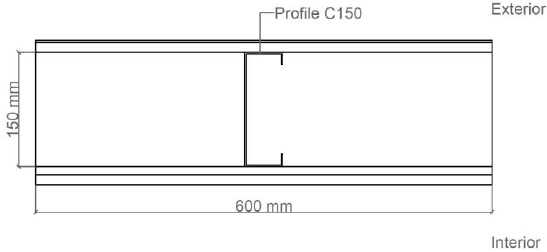
Figure 3. Wall cross-section modelled with FEM software THERM